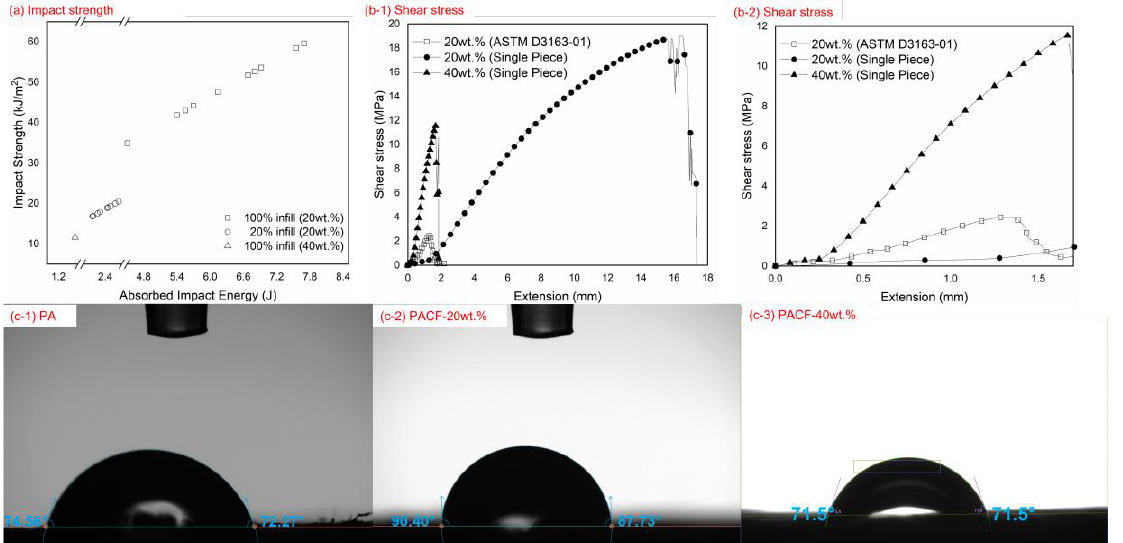
Figure 4. Mechanical performance of the 20 wt.% and 40 wt.% samples, including ( a ) the impact strength analysis, ( b-1 ) the shear stress of single-piece samples in accordance with ASTM D3163-01, ( b-2 ) an enlarged scale of shear stress in ( b-1 ); a contact angle analysis of ( c-1 ) pure PA, ( c-2 ) 20 wt.% CF, and ( c-3 ) 40wt.%